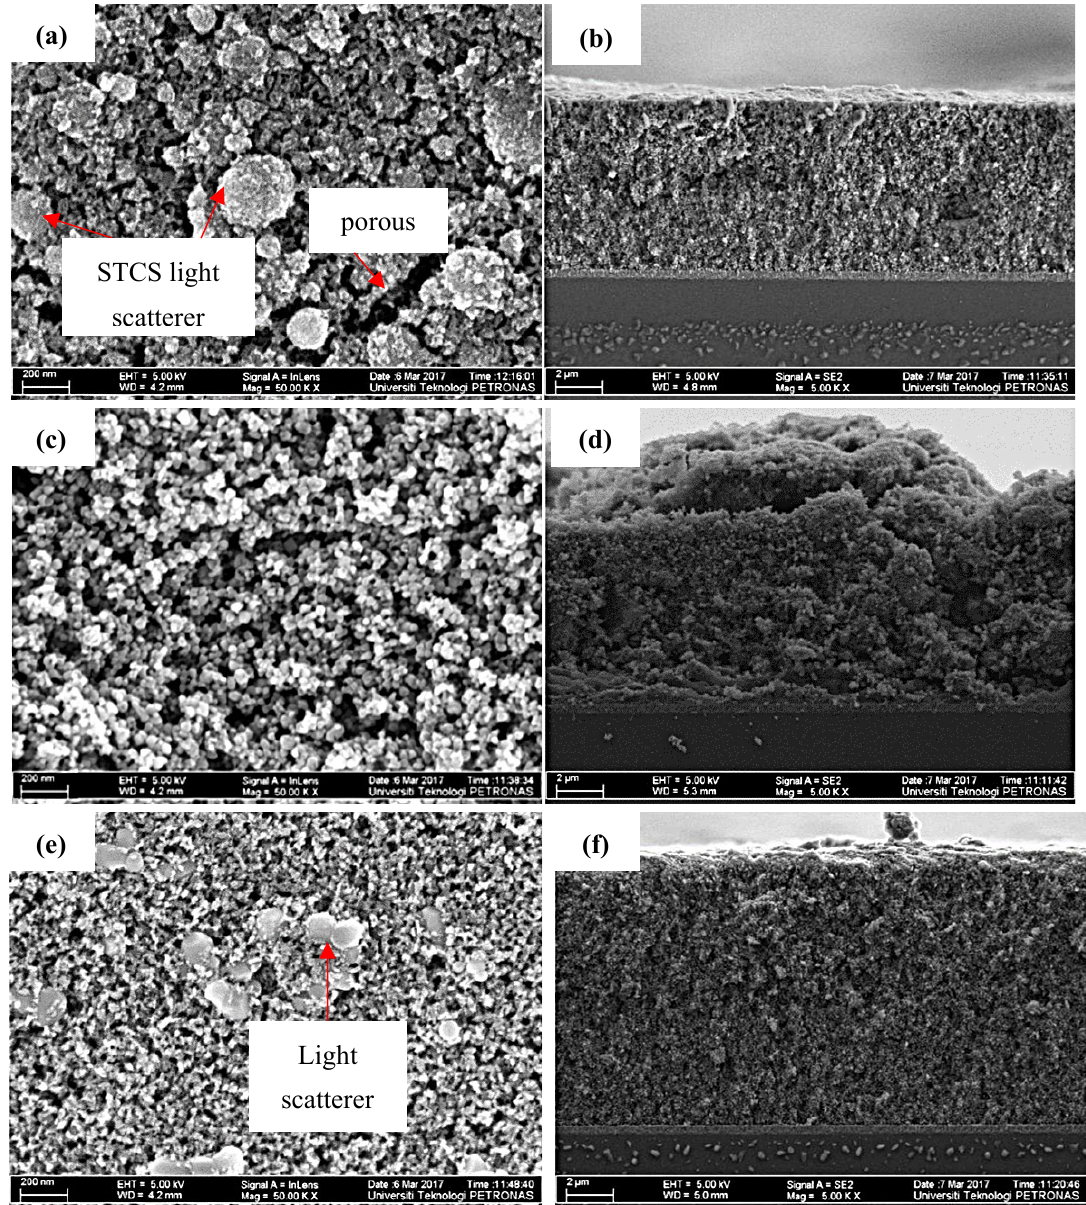
Figure 6. ( a , b ) FESEM images of top and cross-section view of the synthesized sample; ( c , d ) FESEM images of top and cross-section view of the commercial TiO 2 ; and ( e , f ) FESEM images of top and cross-section view of the commercial paste.